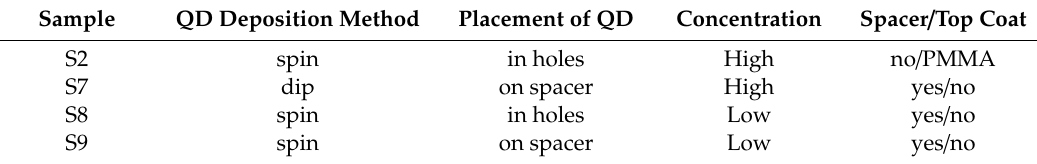
Table 1. Sample description. Spinning was made at 2500 RPM for 30 sec; the quantum dot (QD) concentration was: High = 1 mg / mL; Low 0.25 mg / mL; dipping was made with a high concentration at a speed of 2 mm per minute; the spacer is the 10 nm hafnia on top of the graphene.